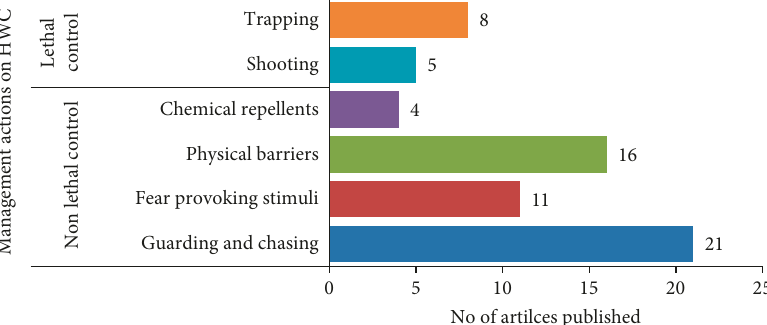
Figure 6: Management actions on HWC recommended by research